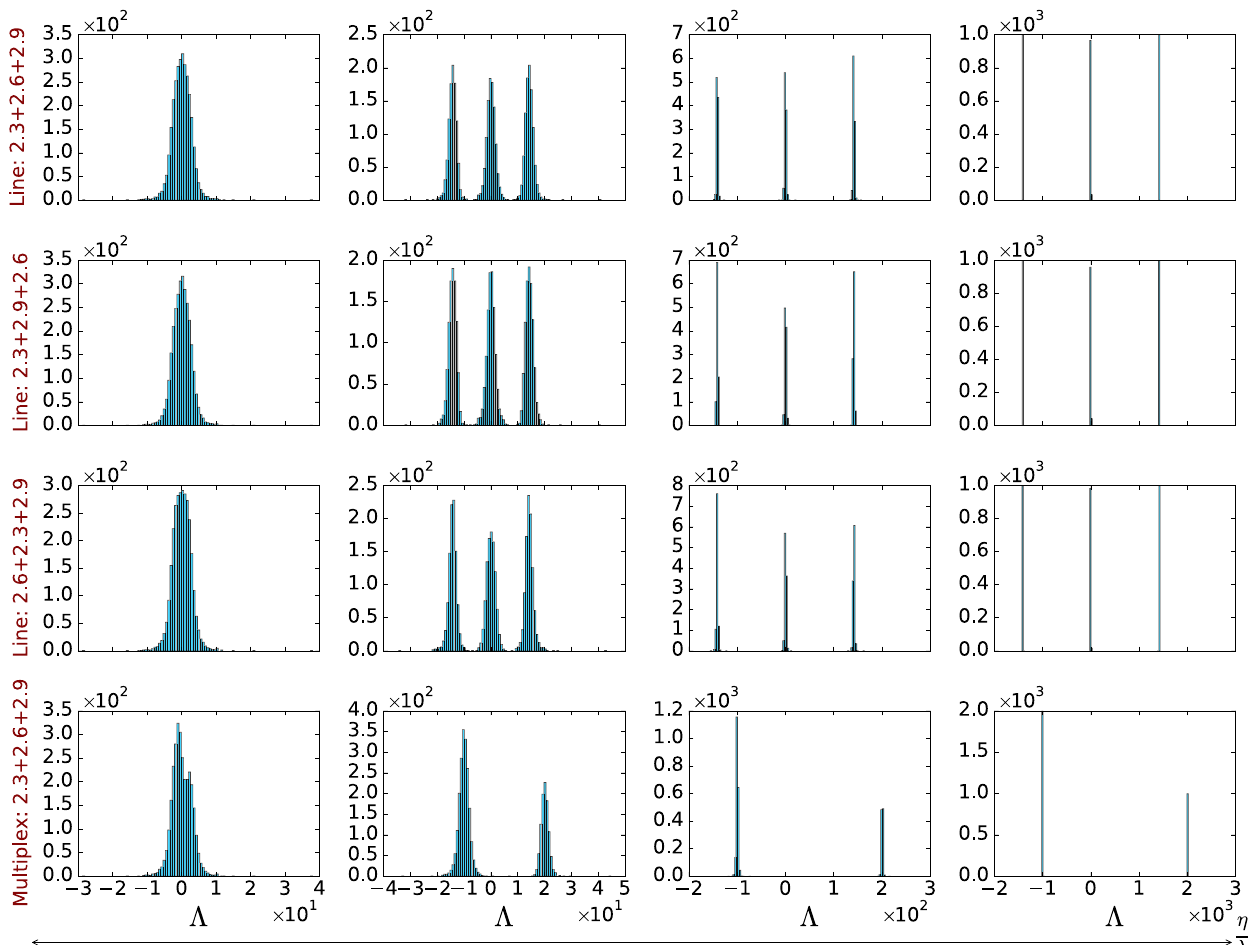
FIG. 15. Distribution of the eigenvalues. In the rows, from top to bottom, we show the interconnected networks of lines 2 . 3 þ 2 . 6 þ 2 . 9 , 2 . 3 þ 2 . 9 þ 2 . 6 , 2 . 6 þ 2 . 3 þ 2 . 9 and the multiplex. In the columns, from left to right, we varied the ratios ð η = λ Þ ¼ 1 , 10, 100, and 1000, respectively. All histograms were built with 100